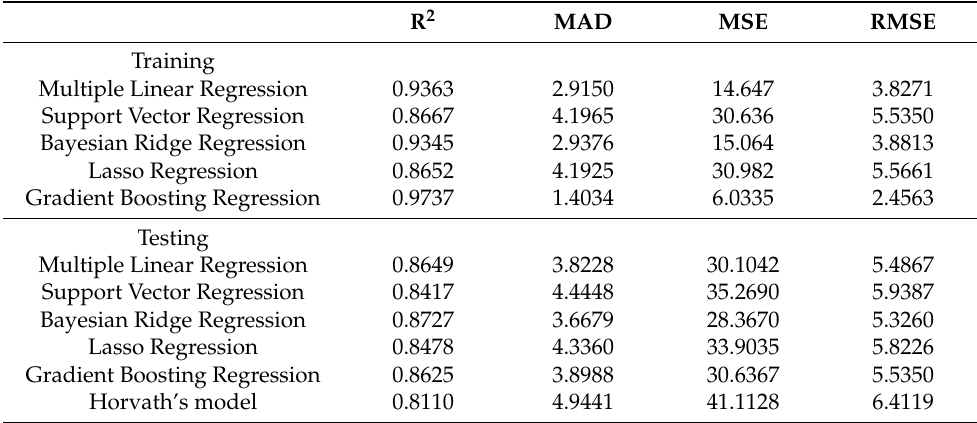
Figure 2. Comparison results between the actual age and predicted age by five different models on the testing healthy data. ( a ) gradient boosting regression, ( b ) multiple linear regression, ( c ) sup- port vector regression, ( d ) Bayesian ridge regression and ( e ) lasso regression.